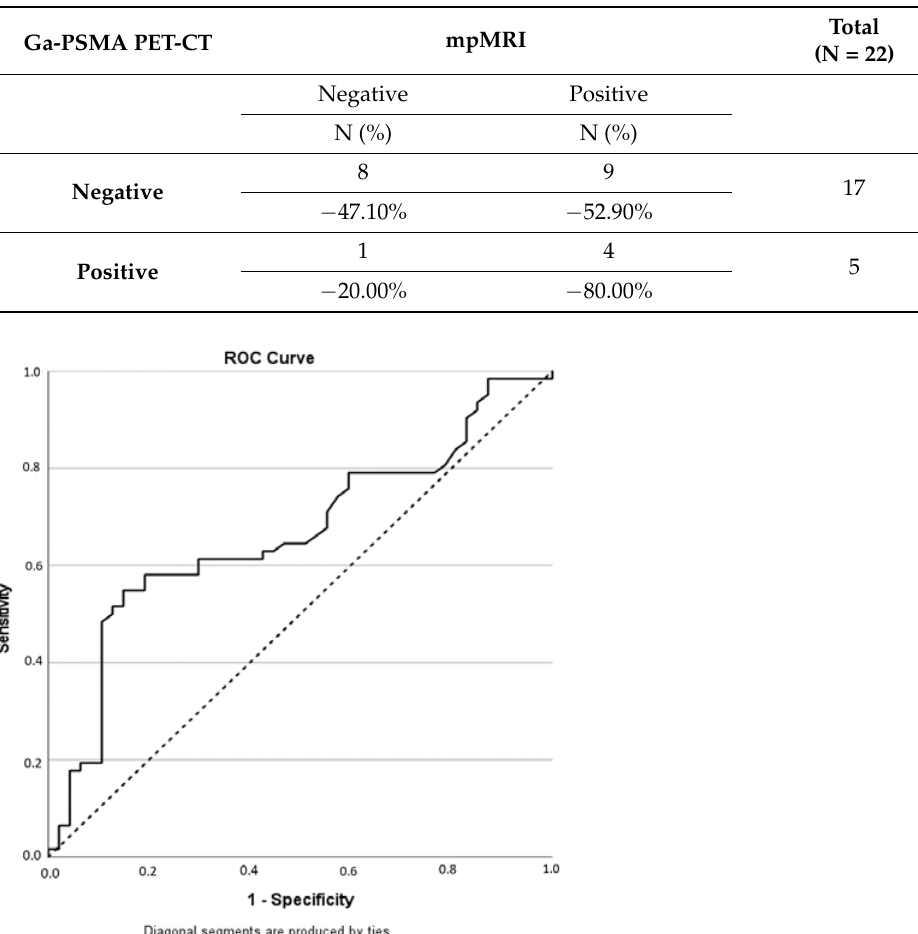
Figure 2. Receiver Operating Characteristic (ROC) curve for PSA predicting a PI-RR Score ≥ 3.